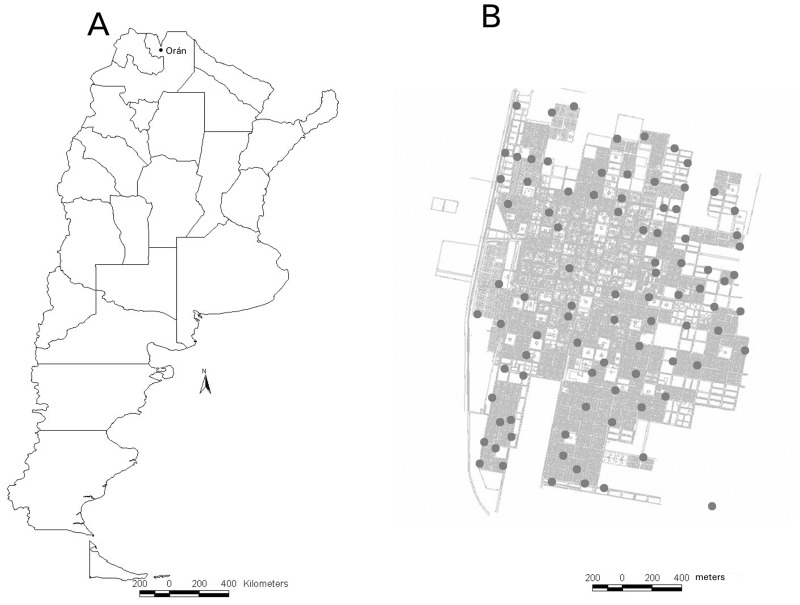
Study site.A: Map of Argentina showing in Salta province (northwestern) the study locality. B: Map of the study locality: San Ramón de la Nueva Orán (4 km X 6 km extension) indicating where the 90 ovitrap were placed. The sampling points were used in spatial patterns of high Aedes aegypti oviposition activity published in an earlier paper (5).